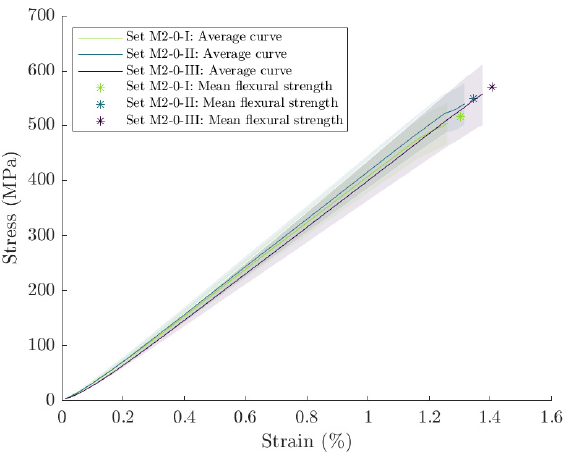
Figure 9. Bending test of CF/PA6 in the longitudinal direction (0° fiber direction): Average stress- strain curves with standard deviation (shadow) and flexural strength (*) for each test set.